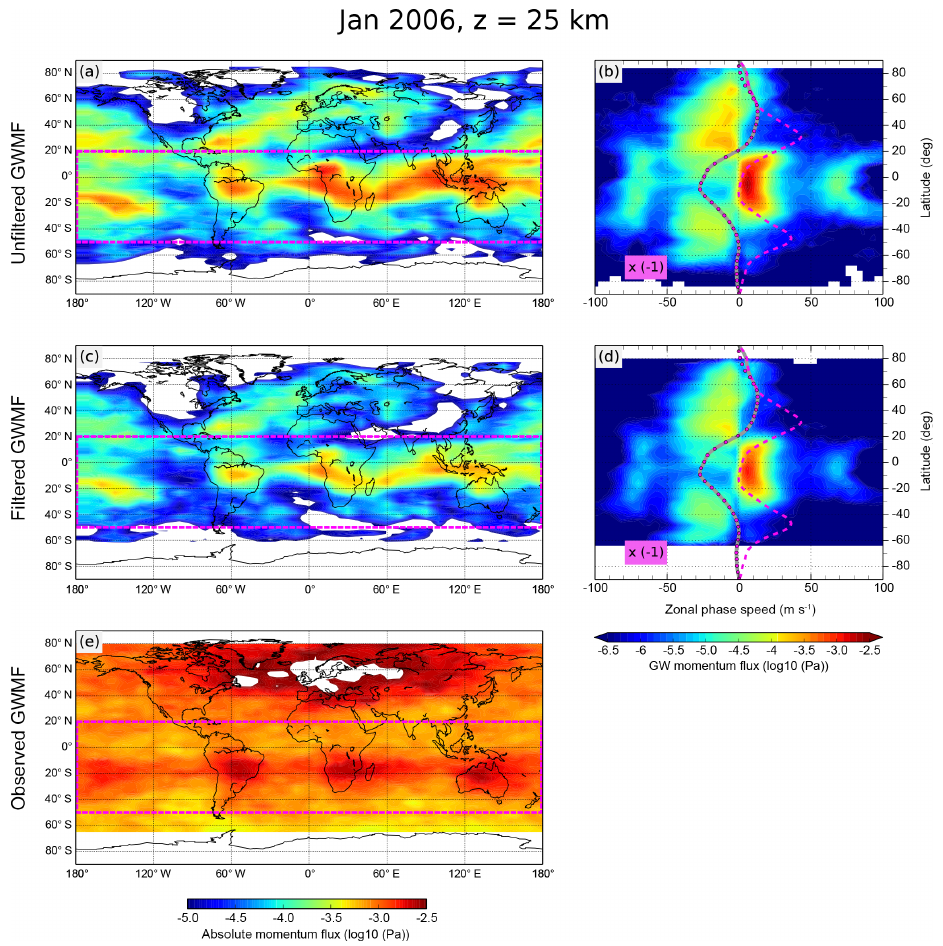
Figure 6. Horizontal distribution of (a) unfiltered absolute GWMF and (c) filtered absolute GWMF in comparison with (e) horizontal distribution of observed absolute GWMF. Panel (b) shows phase speed spectrum of unfiltered zonal GWMF (absolute values) and (d) shows phase speed spectrum of filtered zonal GWMF (absolute values). In phase speed spectra, GWMF values associated with negative values of phase speed (on the left-hand side) are multiplied with − 1. Results are shown for January 2006 at 25km altitude. Simulations were performed using MERRA data. For details see